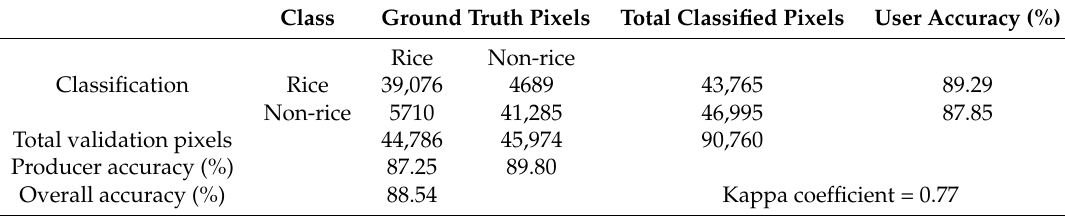
Table 7. The confusion matrix for the rice classification map obtained with